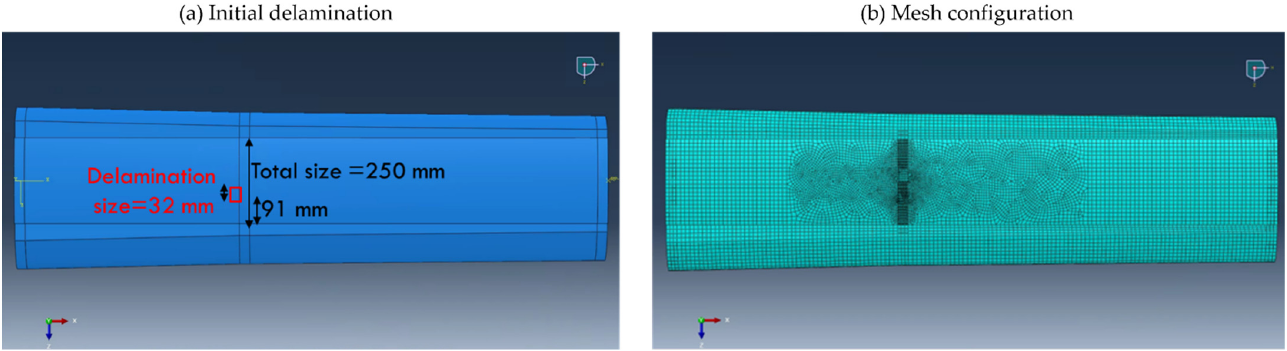
Figure 7. Flight loading spectrum for each fatigue cycle. The bond stat plot (crack propagation plot) output in ABAQUS represents the fatigue crack propagation. The blue color represents the unbonded region, while the red color represents the bonded region. Figure 8 represents the BDSTAT plot for the tail wing structure. The BDSTAT plot was computed between the upper skin and the middle rib of the composite structure.